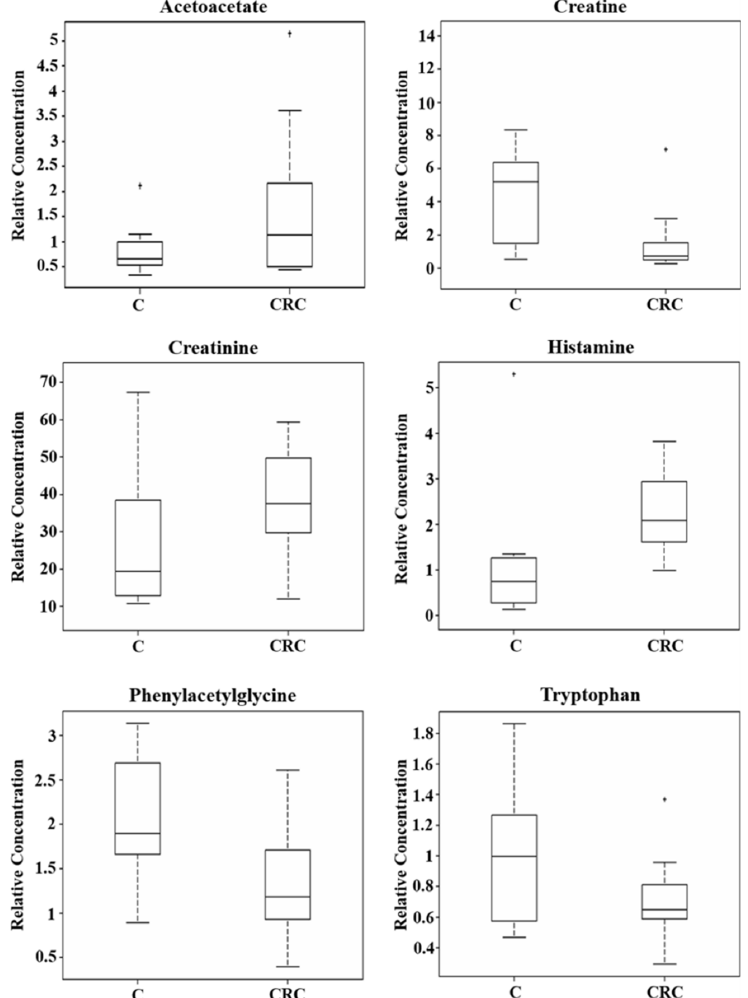
Figure 4. Box-and-whisker plots showing an altered expression of metabolites including acetoacetate, creatine, creatinine, histamine, phenylacetylglycine, and tryptophan between C and CRC patients. Median values are highlighted by solid lines. Statistical significance of the metabolites ( p ≤ 0.05) is presented in Table